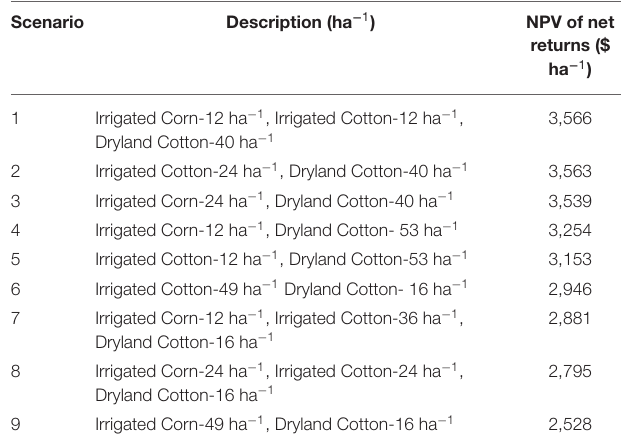
TABLE 2 | Field-level scenarios ranked by net present value of net returns for a representative farm in Hale County, Texas.